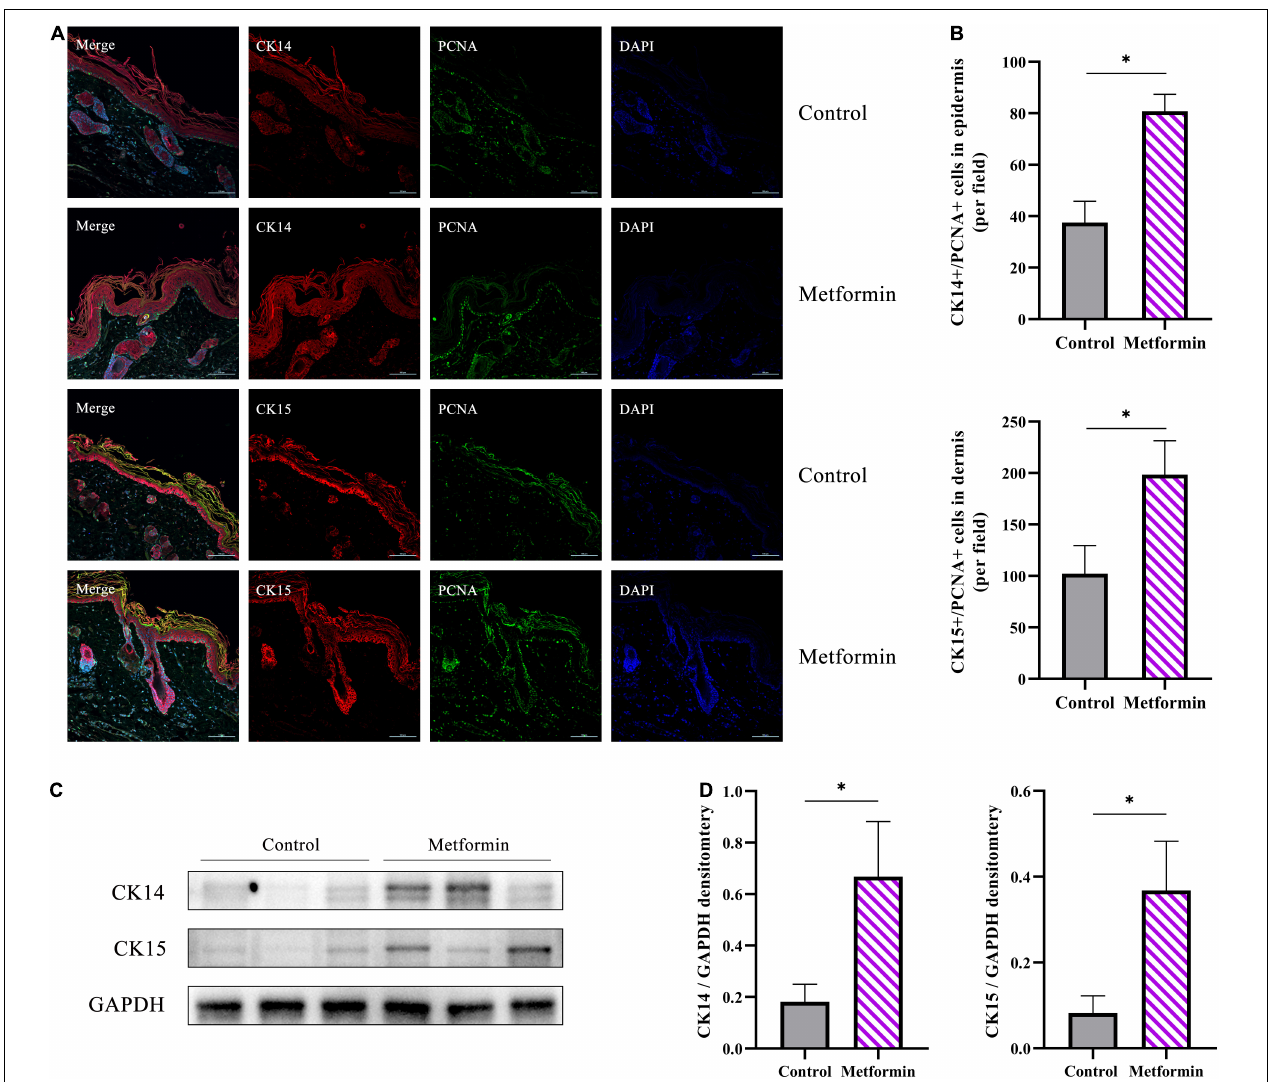
FIGURE 8 | Immunofluorescence staining of mechanically stretched skin. (A) Double-immunofluorescence staining of PCNA (green) and CK14 (red) or CK15 (red) revealed the proliferative status of epidermal stem cells (ESCs) and hair follicle bulge stem cells (HFBSCs). More CK14+/PCNA+ ESCs and CK15+/PCNA+ HFBSCs were identified in mechanically stretched skin from the metformin-treated group than in the control group. (B) Quantitative analysis revealed significantly increased numbers of CK14+/PCNA+ and CK15+/PCNA+ cells in skin samples from the metformin-treated group. (C) Western blot analysis and (D) quantification of CK14 and CK15 protein expression. The results showed that the protein levels of CK14 and CK15 were significantly increased in the metformin-treated group relative to those in the control group. ∗ p <